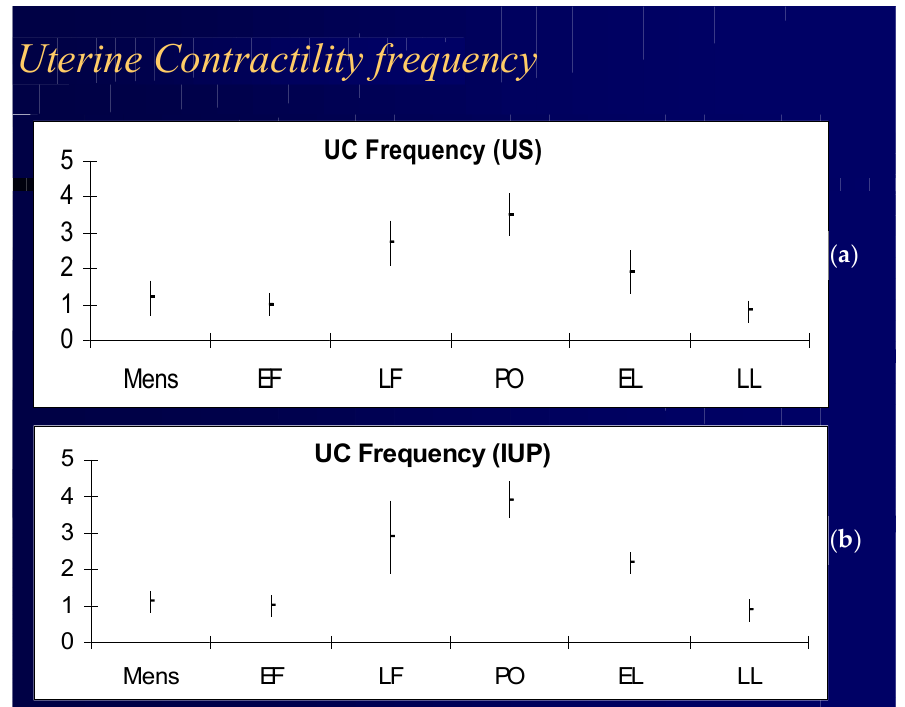
Figure 3. ( a ) Frequency of uterine contractions detected in vivo in a cohort of menstruating women during the menstrual cycle detected with ultrasound (US) and Intrauterine Pressure detection (IUP); ( b ) Timings detected were menstrual cycle (mens), early follicular (EF), late follicular (LF), peri-ovulatory (PO), early luteal (EL), and late luteal (LL) phase of normal menstrual cycles. Adapted with permission from Ref. [62]. Copyright 2000, European Society of Human Reproduction and Embryology